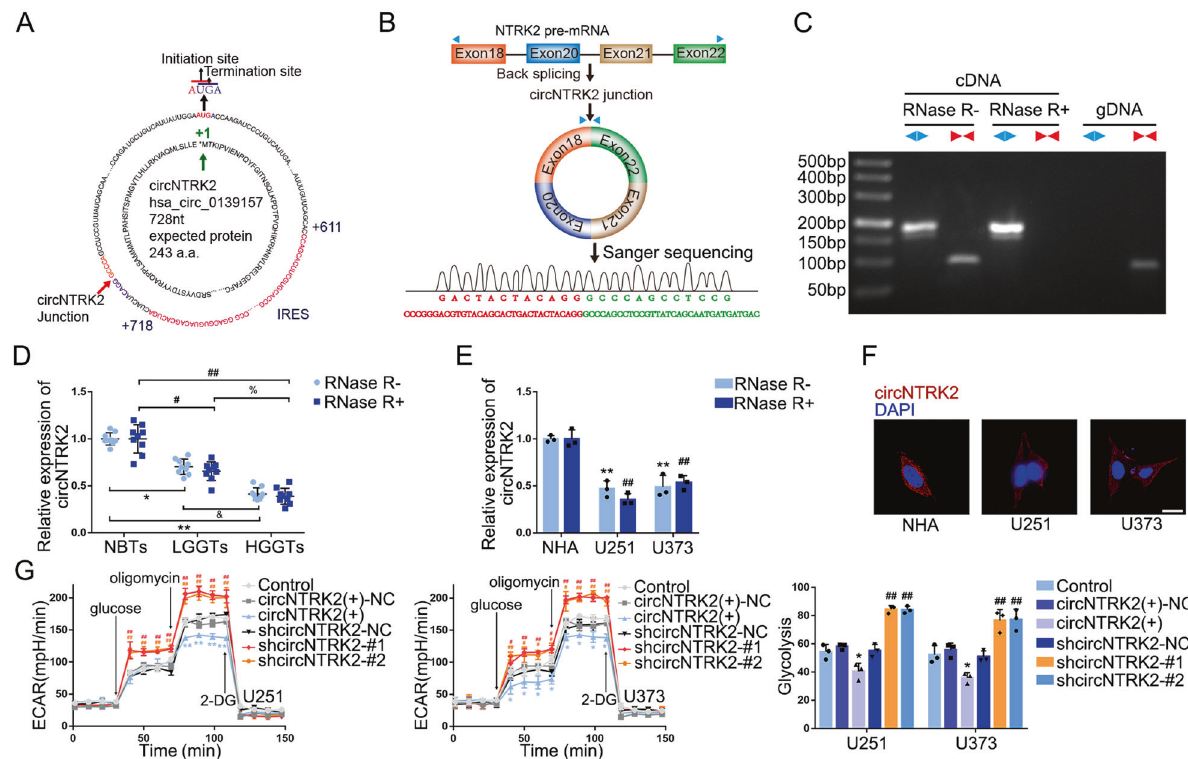
Fig. 2 CircNTRK2 was Downregulated in GBM Tissues and Cells, inhibiting Glycolysis and Proliferation in GBM Cells. A Scheme for circNTRK2 sequence information including junction sequence, IRES, and ORF, as well as NTRK2-243aa sequence potentially encoded. B Scheme illustrates NTRK2 pre-mRNA was back-spliced to form circNTRK2 and the junction sequence was speci fi cally ampli fi ed following Sanger sequencing using diverge primers. C CircNTRK2 was detected in cDNA and gDNA by qRT-PCR with or without RNase R treatment (diverge primers in blue and converge primers in red). D Expression level of circNTRK2 in NBTs, LGGTs, and HGGTs. Data are manifested as mean ± SD ( n = 9, each group). * P < 0.05, ** P < 0.01, compared with RNase R- NBTs group; # P < 0.05, ## P < 0.01 compared with RNase R + NBTs group; & P < 0.05 compared with RNase R- LGGTs group; % P < 0.05 compared with RNase R + LGGTs group. E Expression level of circNTRK2 in U251 and U373 treated with or without RNase R. Data are manifested as mean ± SD ( n = 3, each group). There was no signi fi cant difference between RNase R- and RNase R + groups in NHA, U251, and U373 cells. ** P < 0.01, compared with RNase R- NHA group; ## P < 0.01 compared with RNase R + NHA group. F Distribution of circNTRK2 in NHA, U251, and U373 was determined by FISH. Scale bar represents 10 µm. G Effects of circNTRK2 overexpression or knockdown on ECAR in U251 and U373 cells were determined and glycolysis levels in each ECAR group were analyzed. Data are presented as mean ± SD ( n = 3, each group). * P < 0.05, ** P < 0.01 compared with circNTRK2( + )-NC group; # P < 0.05, ## P < 0.01 compared with shcircNTRK2-NC group. Glycolytic capacity and glycolytic reserve in each ECAR group were analyzed (see Supplementary Fig. 2I,